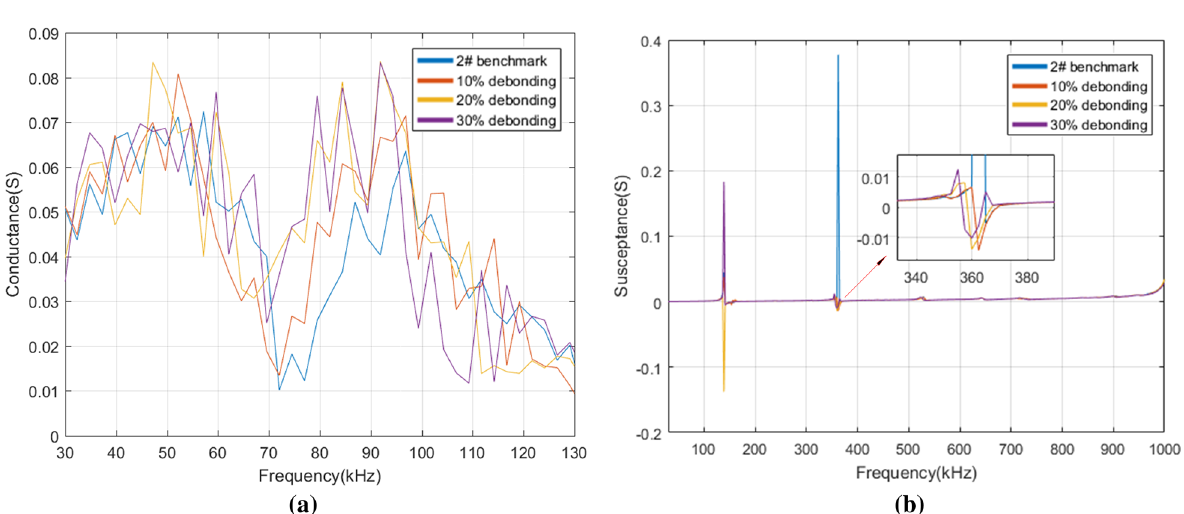
Figure 9. ( a ) The conductance and ( b ) the susceptance of 2# PZT under healthy and different debonding